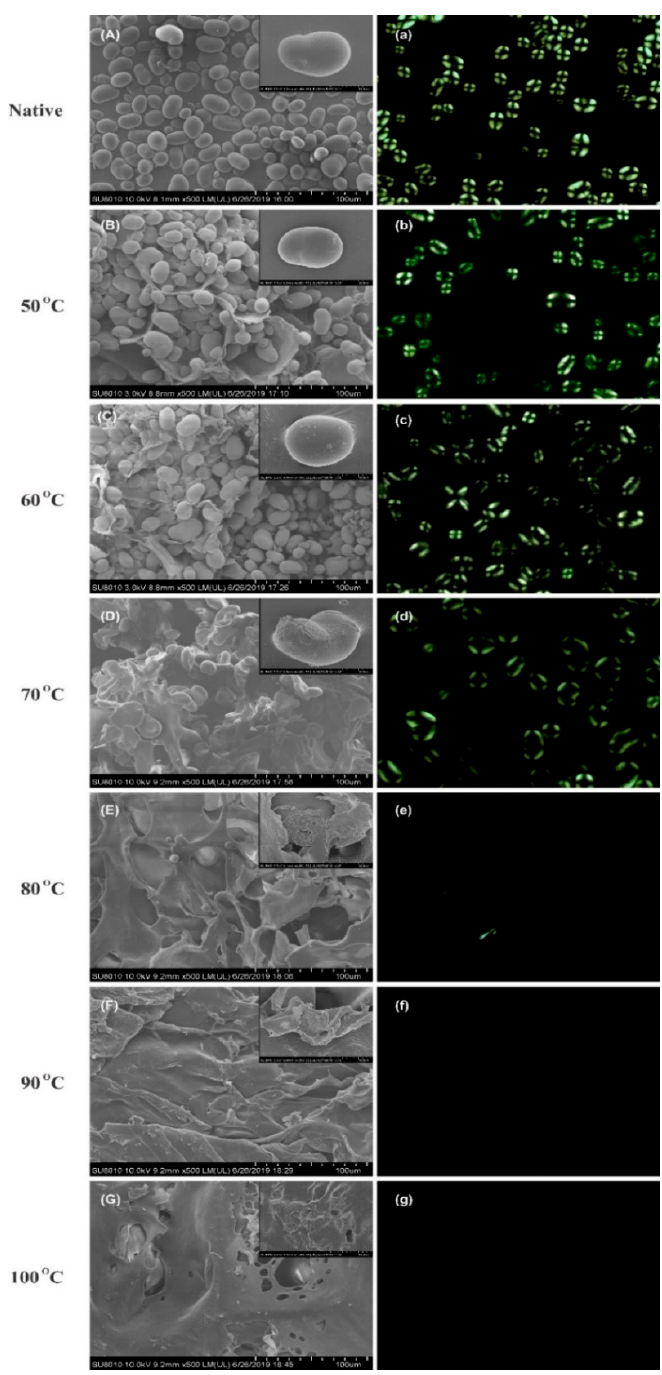
Figure 3. Morphological changes in controlled gelatinized mung bean starch by SEM ( A – G ) and Polarized light microscopy ( a – g